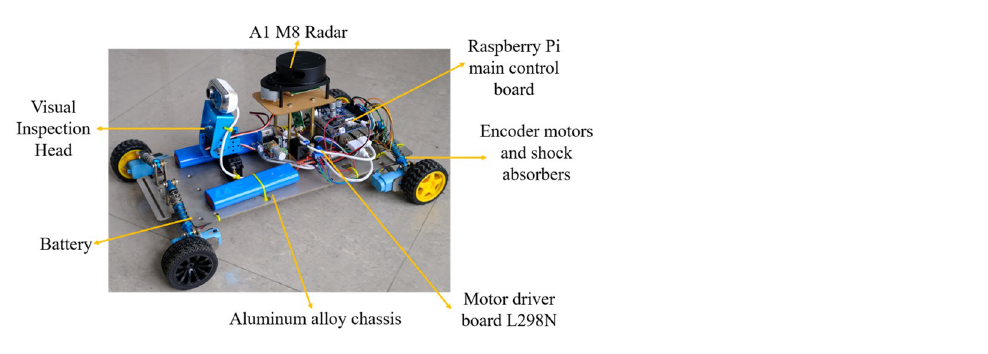
Figure 3. Structural design of the